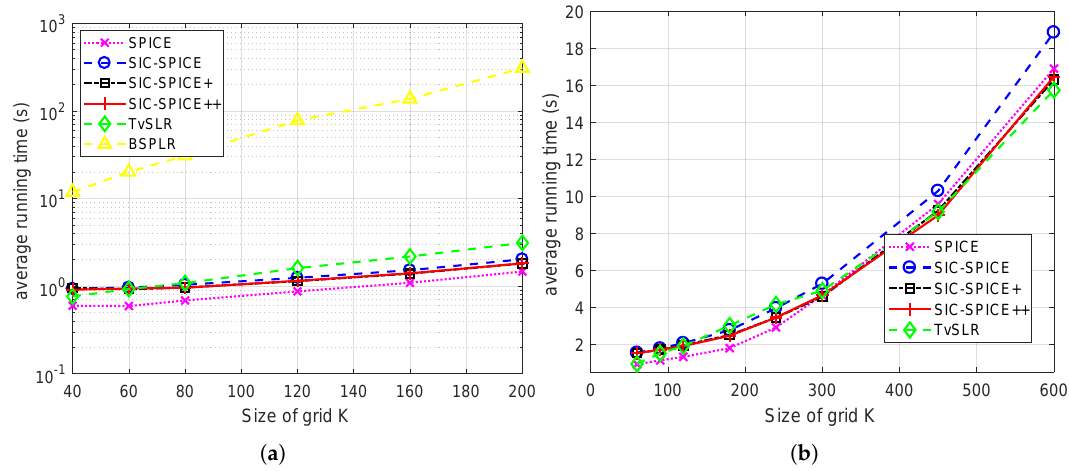
Figure 4. Average running time of different algorithms corresponding to Figure 3. ( a ) N = 20 ( b ) N = 30.